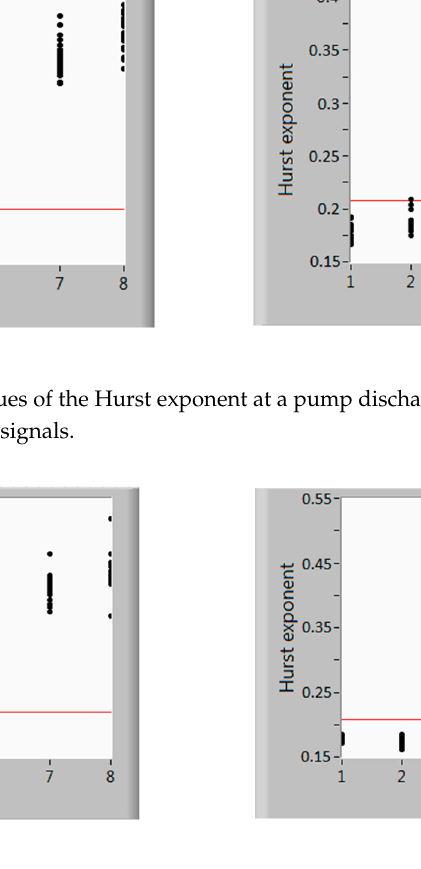
Figure 7. Values of the Hurst exponent at a pump discharge pressure of 2 bar: ( a ) for X-axis signals, ( b ) for Y-axis signals.